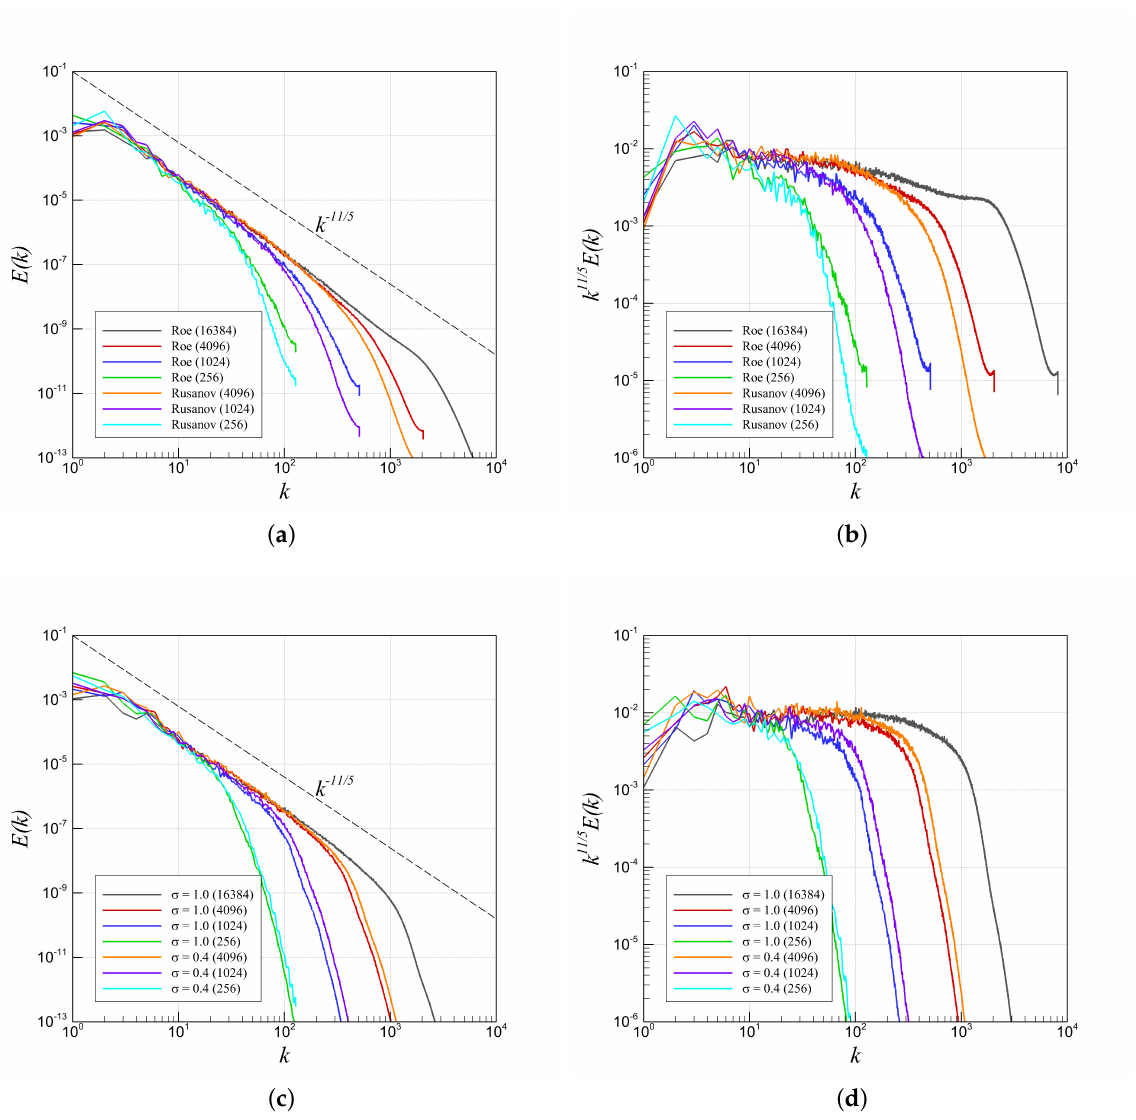
Figure 10. Comparison of ILES (ILES-Roe and ILES-Rusanov) models and CS+RF ( σ = 1.0 and σ = 0.4) models for the RTI problem with multi-mode perturbation showing the kinetic energy spectra and compensated kinetic energy spectra at different resolutions; ( a ) kinetic energy spectra using ILES solvers; ( b ) compensated kinetic energy spectra using ILES solvers; ( c ) kinetic energy spectra using CS+RF solvers; ( d ) compensated kinetic energy spectra using CS+RF